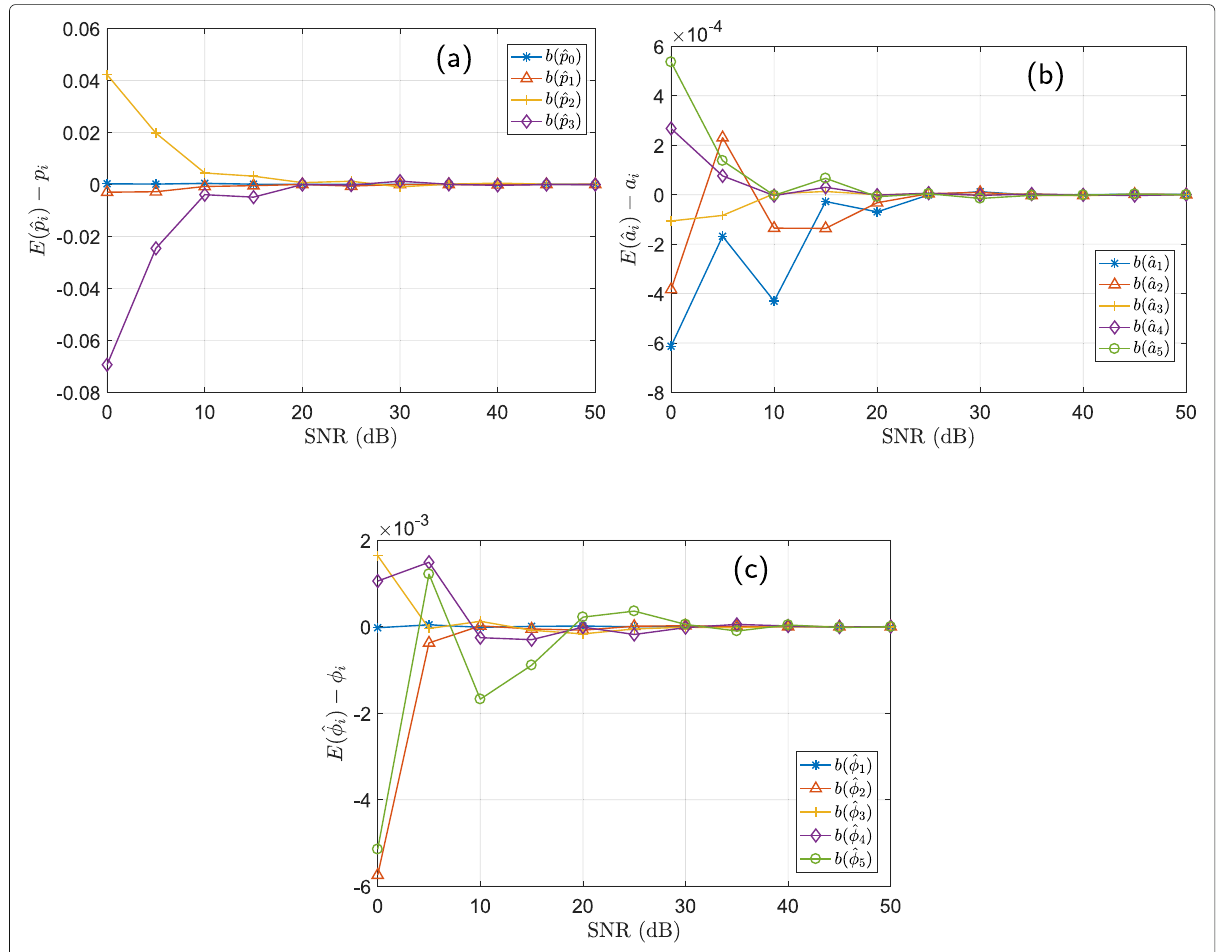
Fig. 6 Bias of the different parameters estimated using the TCE algorithm. a Bias of ˆ p , p = [1.9, − 9,8.5, − 4] T . b Bias of ˆ a , a = [1.8,0.5,0.2,0.1,0.05] T . c Bias of ˆ φ , φ = [ − 3,3,2.5,1.5,1] T . We used 1000 Monte-Carlo